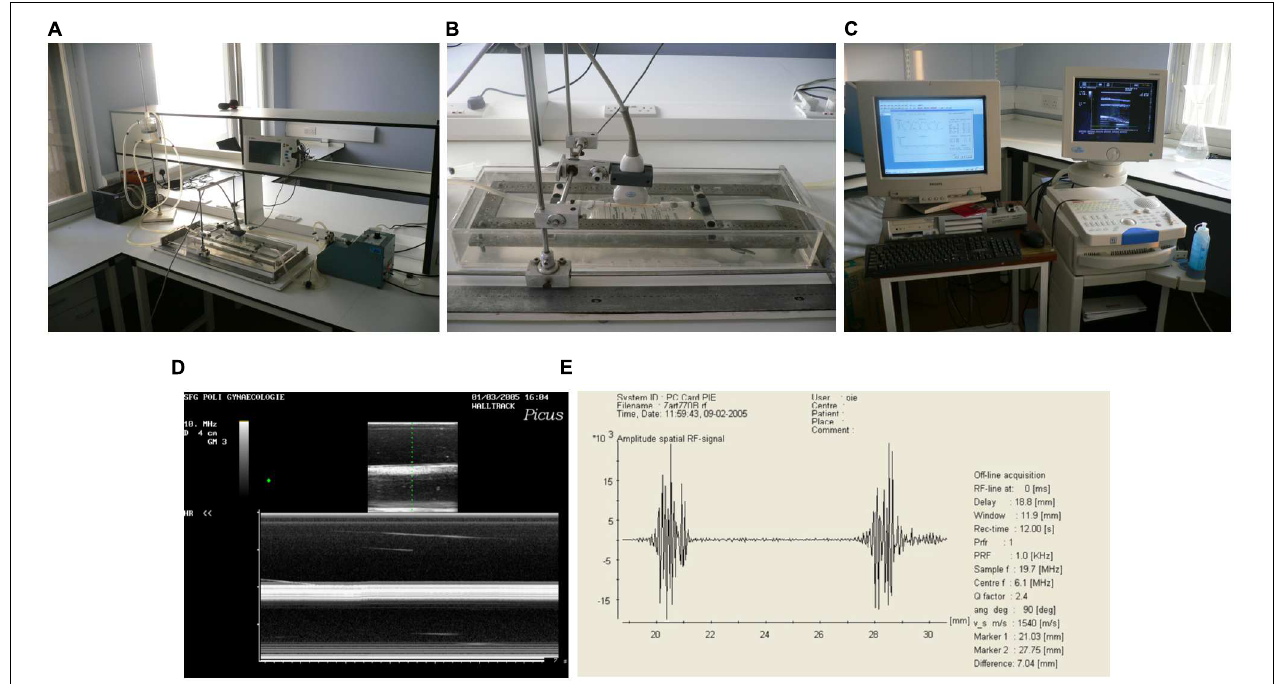
FIGURE 1 | Arterial pulsatile flow circuit. (A) Photograph of the flow circuit apparatus. (B) Detail of the perspex/saline bath and ultrasound probe in flow circuit. (C) Photograph of the ultrasound machine and wall tracking system. (D) B-mode (top) and M-mode (bottom) ultrasound images of the graft mounted in flow circuit. (E) Signal generated by anterior and posterior walls of the